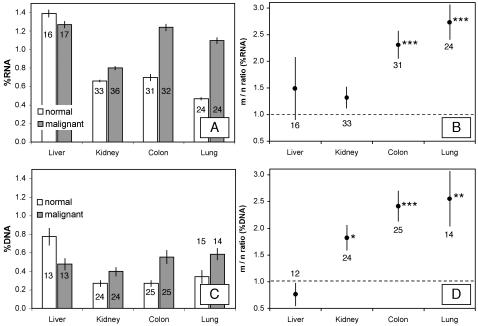
Absolute and relative (malignant/normal) values of biochemical parameters in normal and malignant tissues of liver, kidney, colon, and lung.A. and B. RNA content. C. and D. DNA content. Data are expressed as in Figure 1.